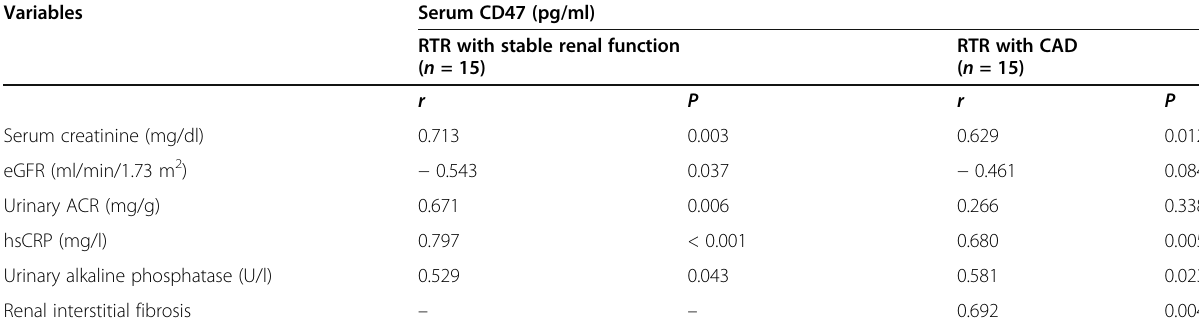
Table 3 Statistical correlations between serum serum CD47 levels (pg/ml) on the one hand and renal function, high-sensitivity C- reactive protein (hsCRP), urinary alkaline phosphatase, and degree of renal fibrosis on the other hand in renal transplant recipients (RTR) with stable renal function and chronic allograft dysfunction (CAD) Variables Serum CD47 (pg/ml) RTR with stable renal function RTR with CAD ( n = 15) ( n = 15) r P r P Serum creatinine (mg/dl) 0.713 0.003 0.629 0.012 eGFR (ml/min/1.73 m 2 ) −